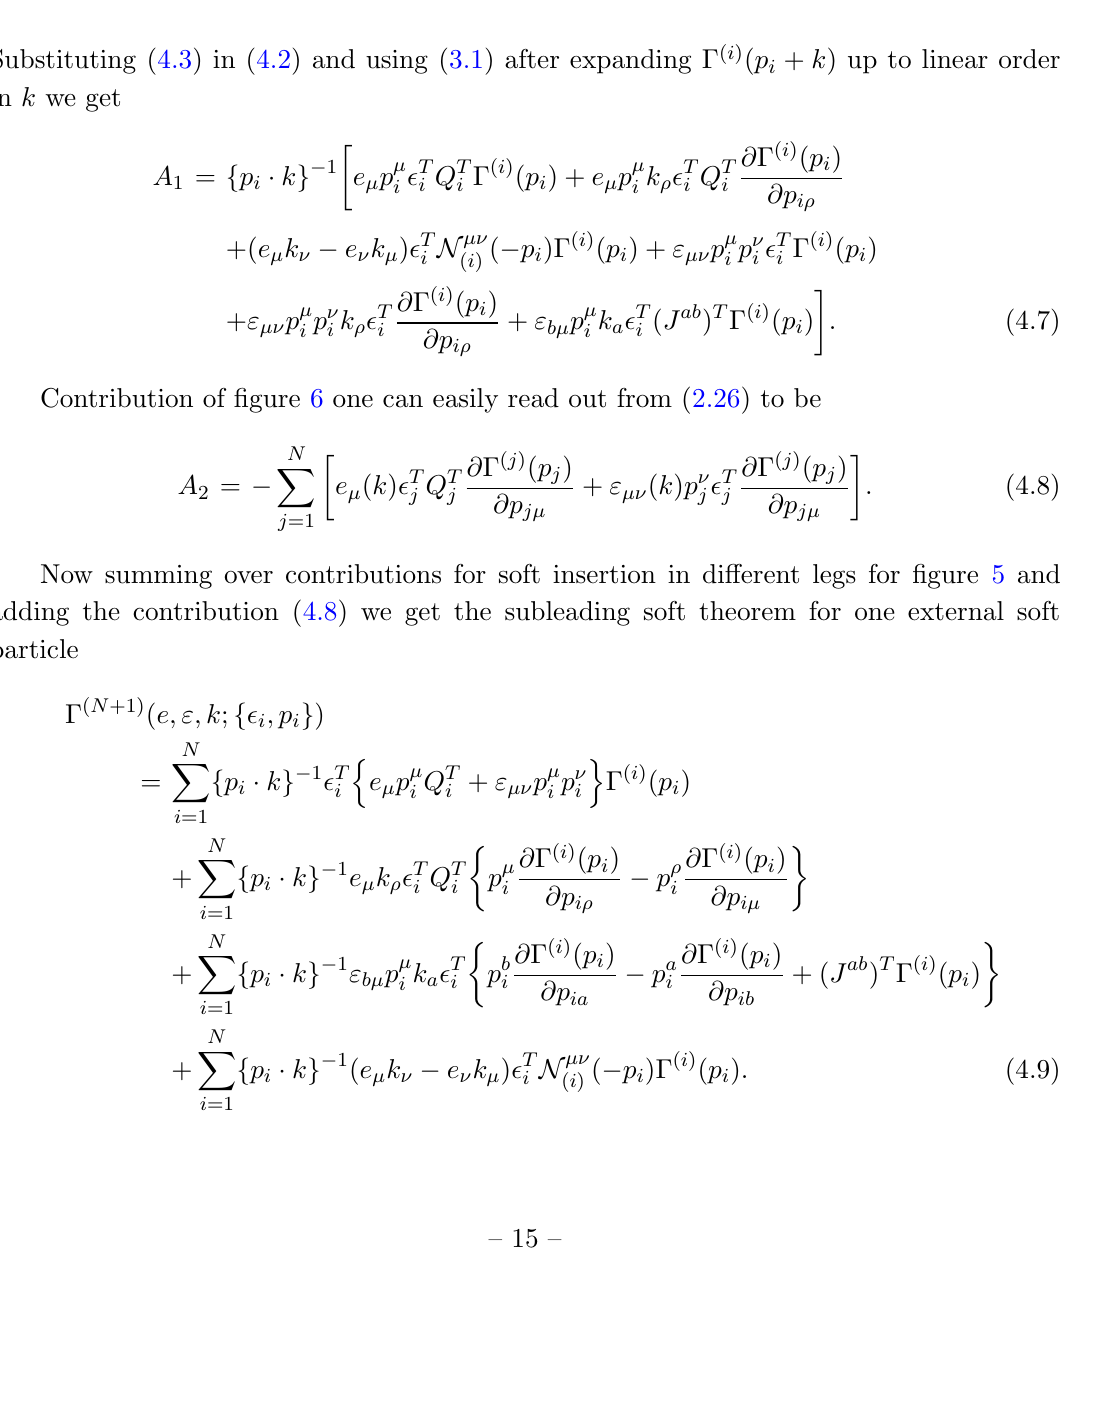
Figure 6 . Diagram start contributing at subleading order being the soft particle is not attached to any external